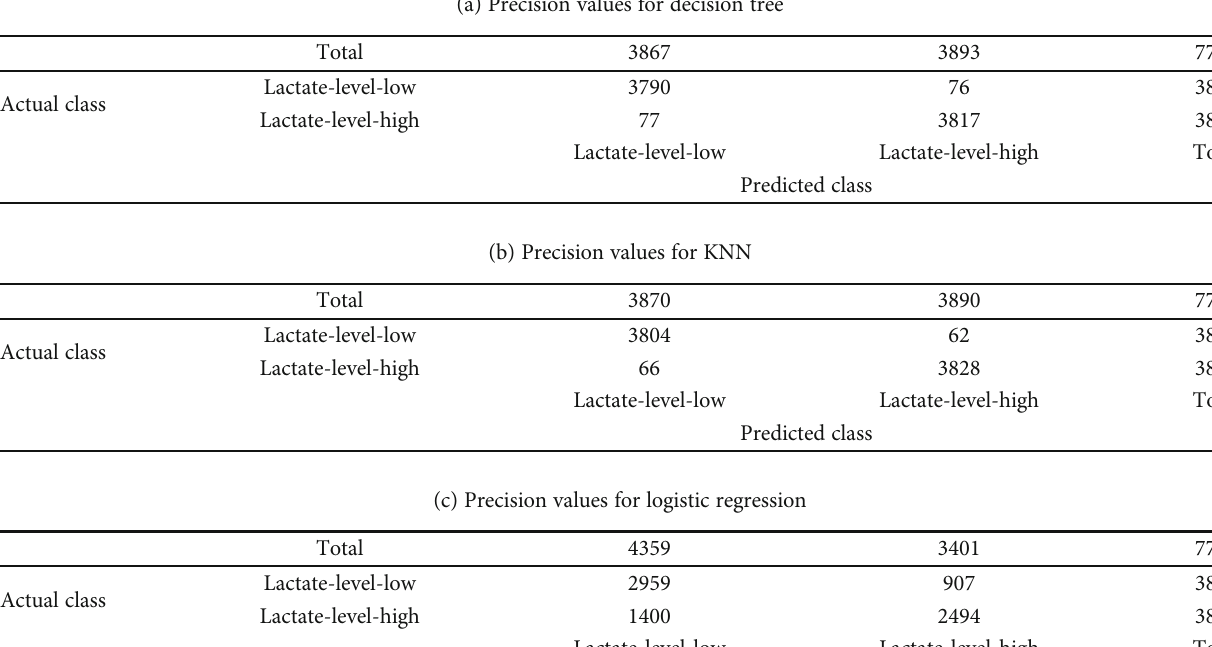
Table 3: Precision values for di ff erent classi fi ers.